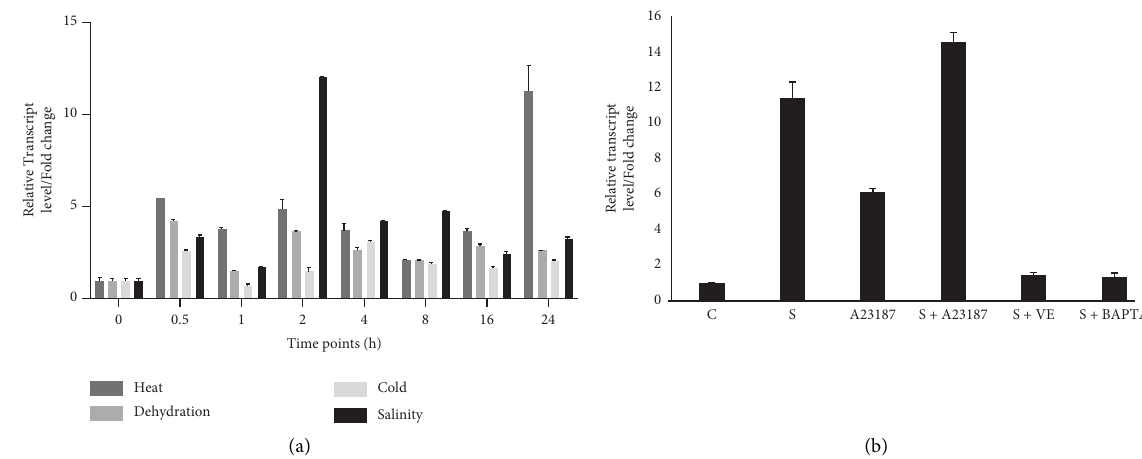
Figure 2: Expression analysis of OsPAO3 . Te expression analysis was performed from the O. sativa seedling/protoplast after the treatments. Extraction of RNA was conducted by RNeasy plant mini kit (Qiagen), followed by cDNA synthesis (high-capacity cDNA reverse transcription kit, Termo Fisher Scientifc). Te cDNA obtained was used for expression analysis by real-time PCR using TaqMan probes. OsPAO3 and OseEF1 were labeled with the FAM MGB probe and VIC MGB probe (custom TaqMan ™ gene expression assay), respectively. Te assay was conducted by multiplexing. Te assays were repeated with a minimum of three replicates, and ΔΔ CT values were calculated; relative transcript level (fold change) was determined, and the graph was plotted. Te y -axis shows the fold change while the x -axis in (a) shows the time points of abiotic stress treatment, and (b) shows various chemical treatments: C, control; S, sodium chloride (200 mM); A23187 (calcium ionophore, 50 µ M); VE, verapamil (calcium channel blocker, 2mM); and BAPTA, calcium chelator (2mM). Te data represent three biological replicates, and error bars have been